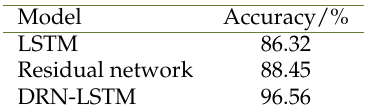
Table 1. Comparison of